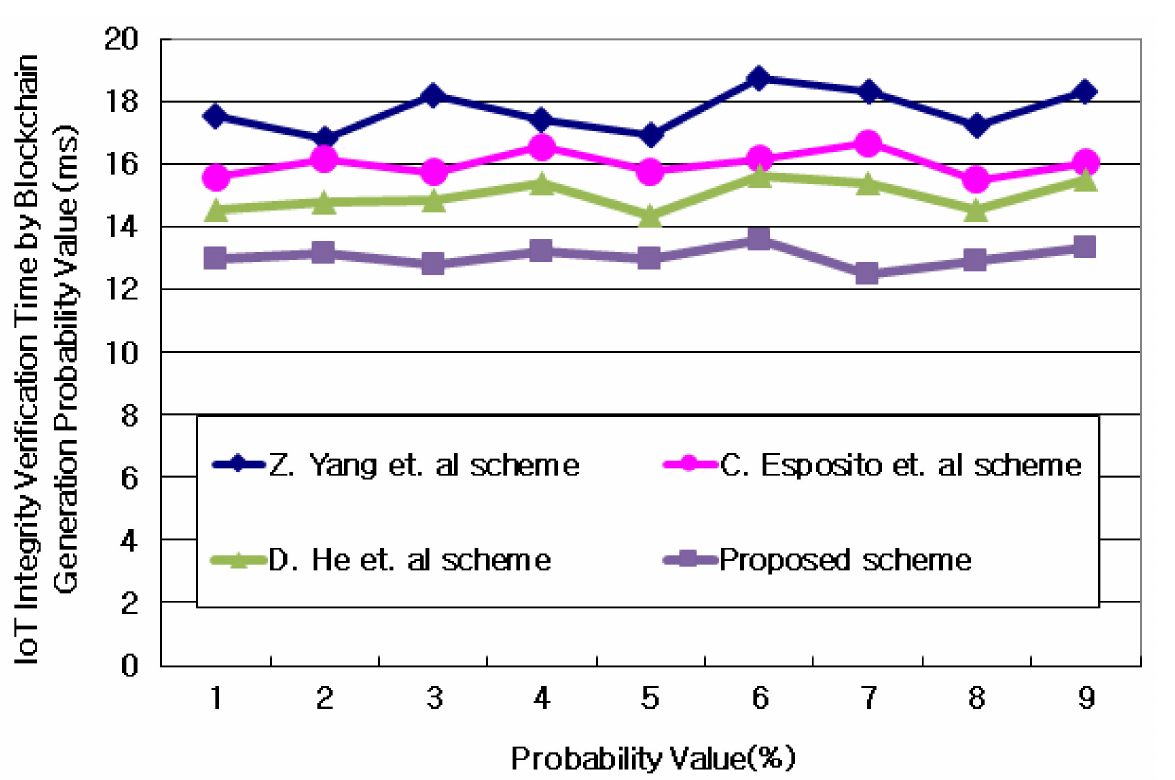
Figure 7. Time to verify IoT integrity based on the probability value of creating a blockchain.